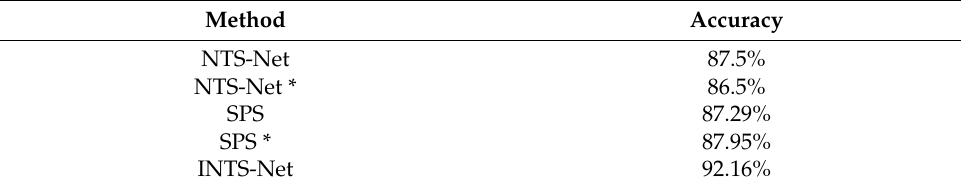
Table 2. Comparisons on CUB-200-2011 dataset. * refers to the model we